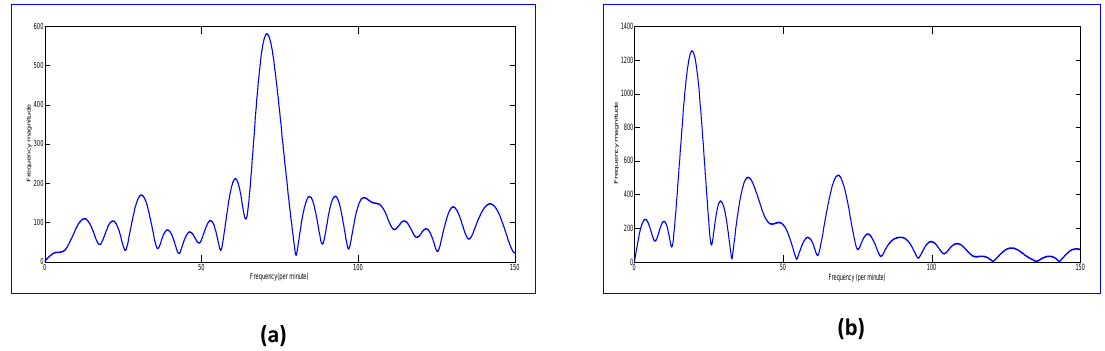
Figure 12. Experimental setup when the radar is pointed at the back of the subject.